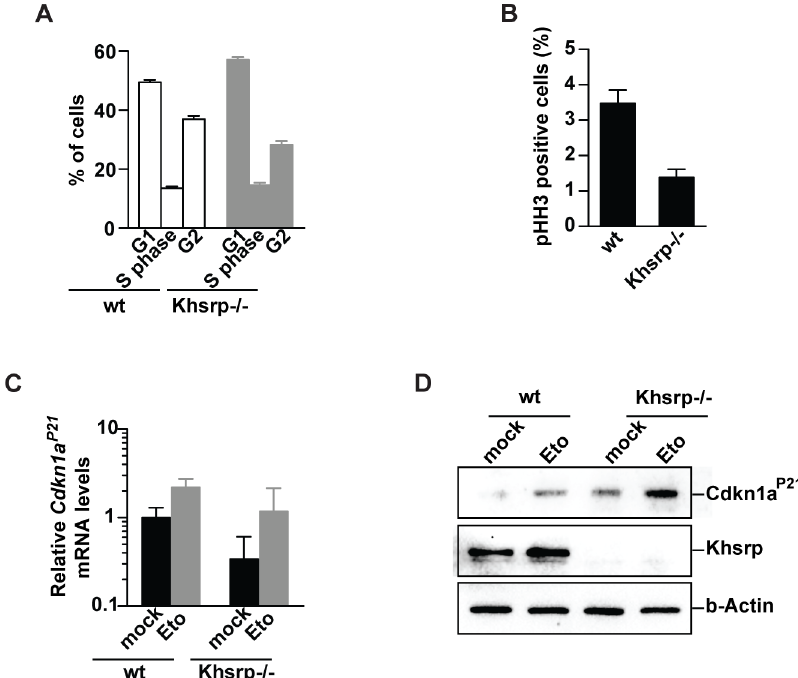
Fig 5. Khsrp-dependent regulation of Cdkn1a P21 . (A) Cell cycle analysis and (B) mitotic index of wildtype and Khsrp -/- MEFs expose a Khsrp -dependent (A) accumulation of cells in G 1 and (B) decreased cycling rates. (C) Transcript and (D) protein levels of Cdkn1a P21 in Khsrp -/- cells measured by qPCR and immunoblotting reveals an increase of Cdkn1a P21 protein levels unrelated to Cdkn1a P21 mRNA levels.